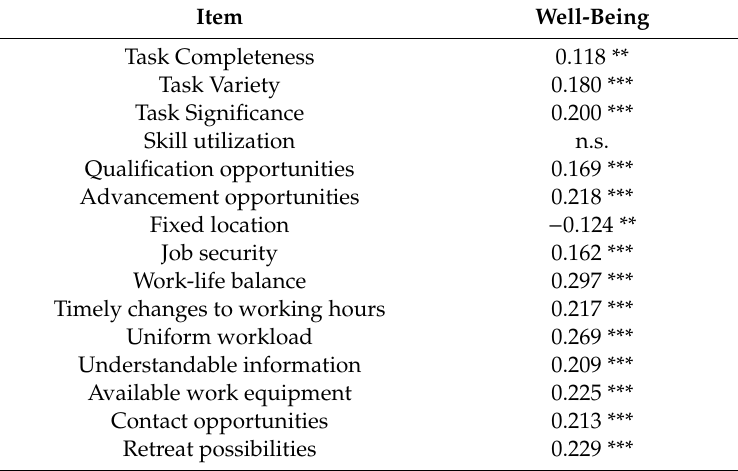
Table A1. Criterion-related validity for single